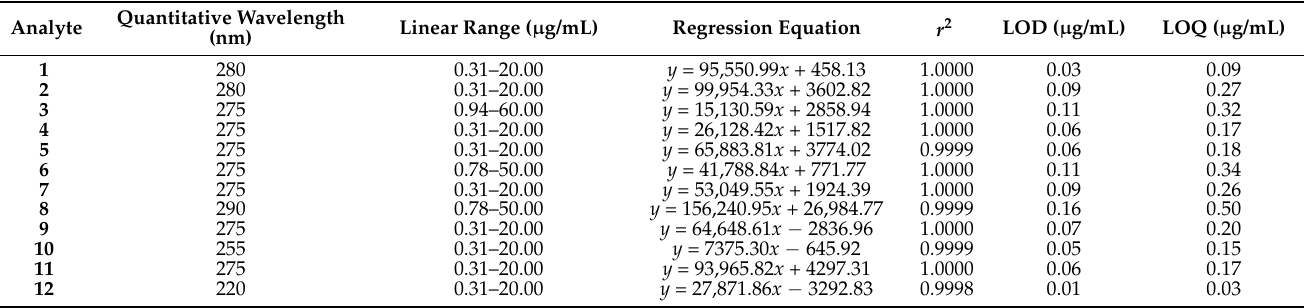
Table 3. Linear range, regression equation, r 2 , LOD, and LOQ for the 12 markers determined by HPLC analysis ( n = 3).